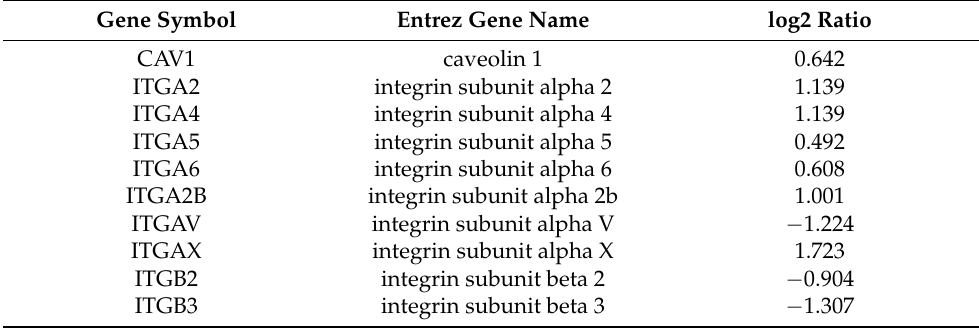
Table 2. Integrin signaling genes. Identified as a top canonical pathway by